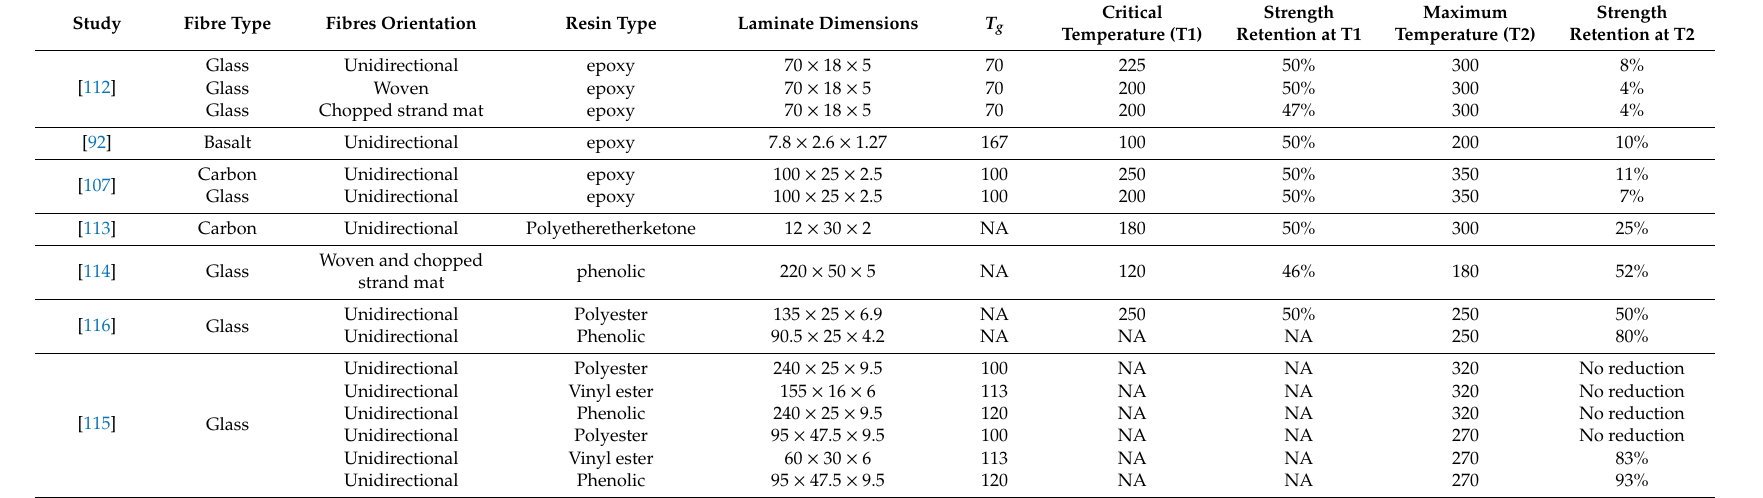
Table 4. FRP laminates / sheets flexural and interlaminar shear properties after exposure to elevated